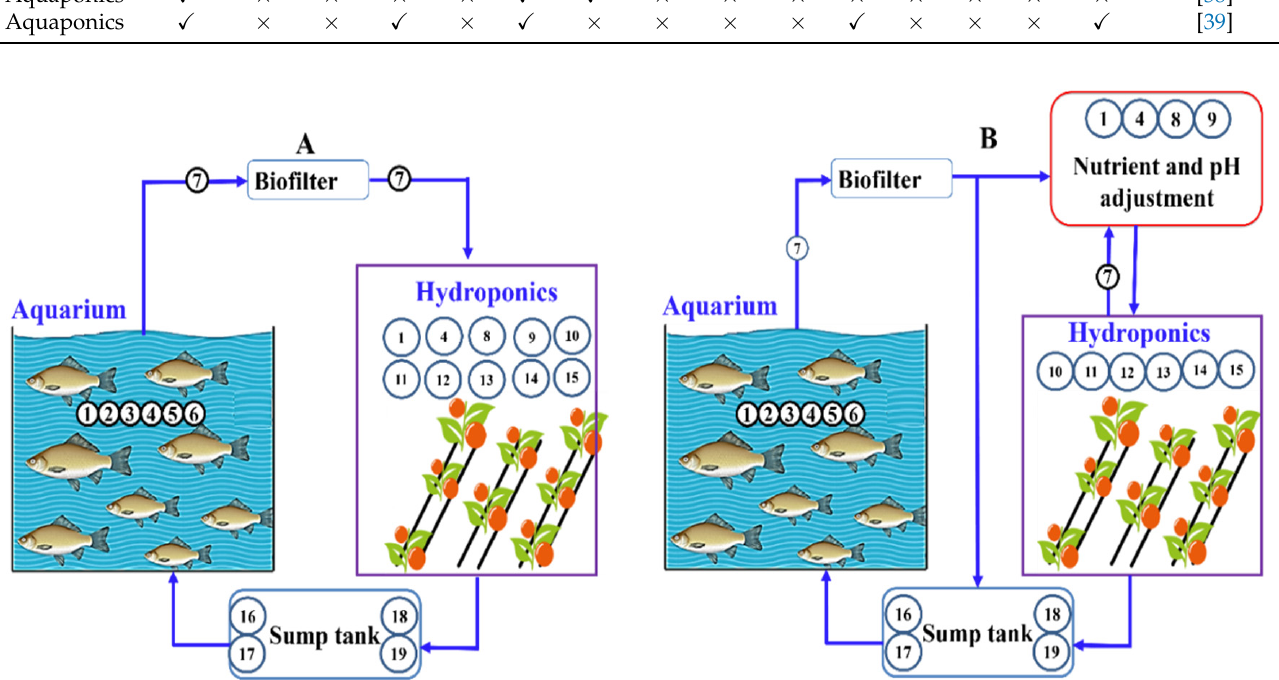
Figure 4. Location of sensors in coupled ( A ) and decoupled ( B ) aquaponics systems: pH 1, Water temperature. 2, Level 3, DO 4, TAN 5, NO 2 6, Flow 7, EC 8, NO 3 9, Air T. 10, RH 11, CO 2 12, Light 13, Moisture 14, Plant Height 15, TDS 16, SL 17, Water hardness 18, and Alkalinity Table 1. List of sensed parameters, smart systems, and IoT systems in selected aquaponics, hydro ‐ ponic, or aquaculture publications.